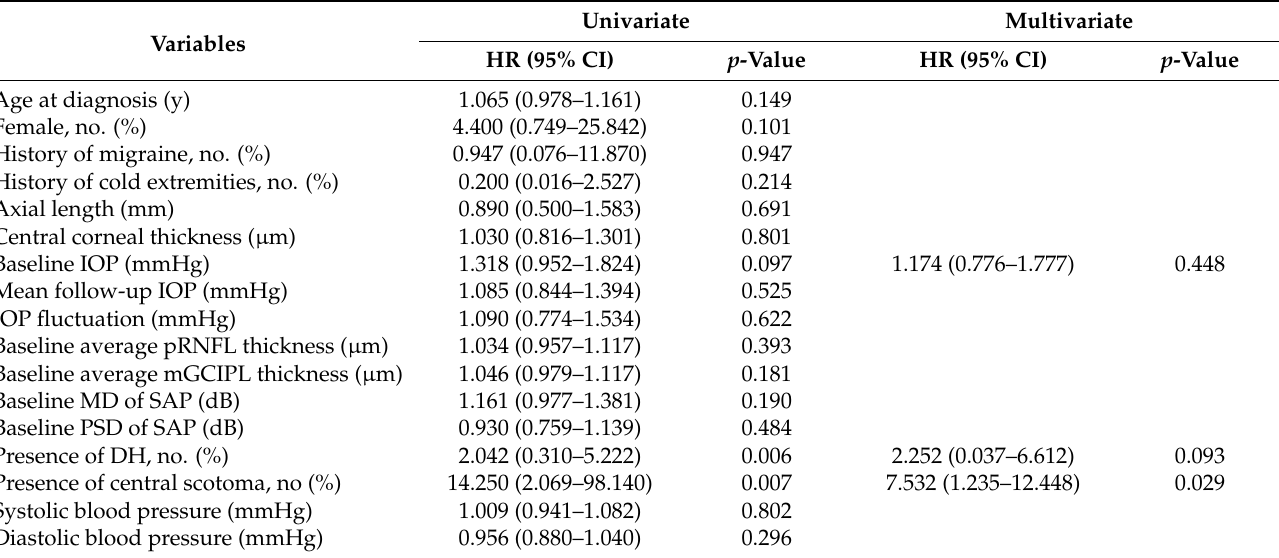
Table 5. Factors associated with TNF- α -positive in the aqueous humor of normal tension glaucoma